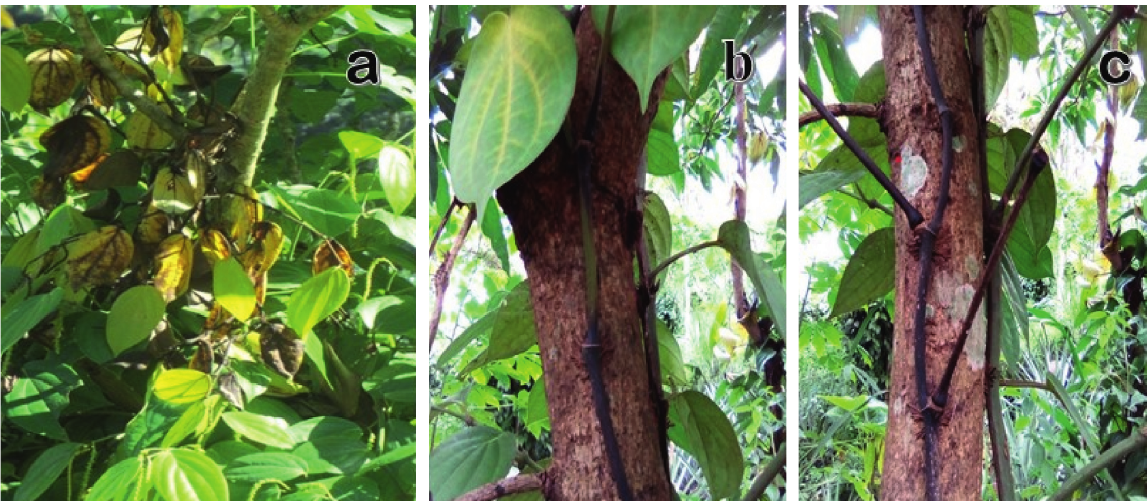
Figure 2: Appearance of wilted pepper plants. (a) Foliar yellowing and wilting internodes on pepper cultivar Ismailia at the upper part of the canopy. (b) Unilateral necrosis of the internode. (c) Shedding of leaves.